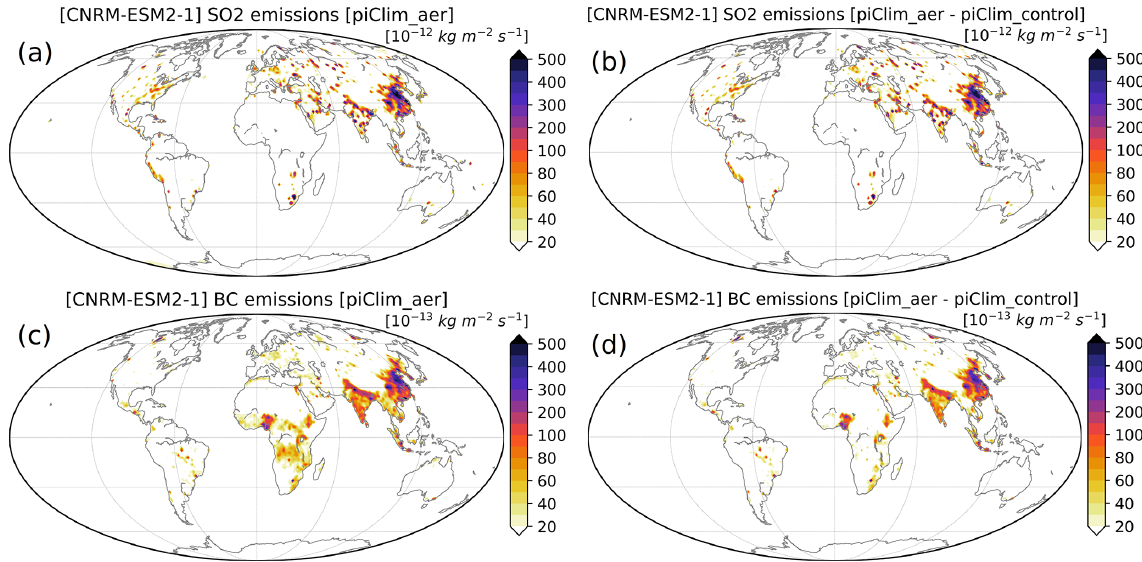
Figure 1. SO 2 (in 10 − 12 kgm − 2 s − 1 ) and BC emissions (in 10 − 13 kgm − 2 s − 1 ) for 2014 ( a and c ) used in CNRM-ESM2-1 piClim-aer simulation and differences in annual SO 2 and BC emissions between year 2014 (in piClim-aer) and year 1850 (in piClim-control) ( b and d ). Mind that the scale for BC emissions is by a factor of 10 lower than for SO 2